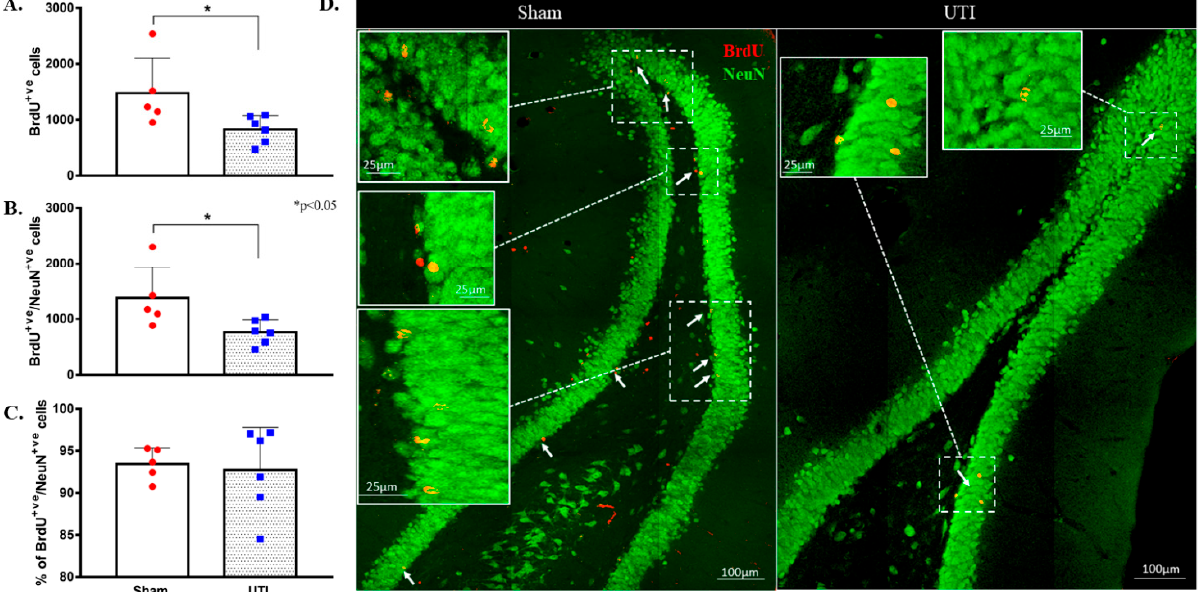
Figure 6. Decrease in neurogenesis persists on day 34 post infection. ( A ) Stereological quantification of the BrdU-labeled cells in the DG of sham rats ( n = 5) and rats with a UTI ( n = 6) sacrificed on day 34 post infection. ( B ) Stereological quantification of BrdU/NeuN double-labeled cells in the DG of sham rats and rats with a UTI. ( C ) Percentage of BrdU/NeuN double-labeled cells out of total BrdU-positive cells in the DG of sham and rats with a UTI. An unpaired Student’s t -test was used to determine the statistical significance between the sham and UTI groups. ( D ) Representative confocal images showing immunofluorescence labeling of NeuN (green) and BrdU (red; arrows) in the DG of sham rats and rats with a UTI. Images were taken as Z stacks and tile scan using a 40 × -oil objective. table in the intermediate (152 ± 23; p = 0.04) and caudal DG (434 ± 50; p = 0.02) of rats with t -test). As for the rostral DG, the total number of BrdU-positive cells was comparable between sham (365 ± 89) and UTI rats (233 ± 41) (Figure